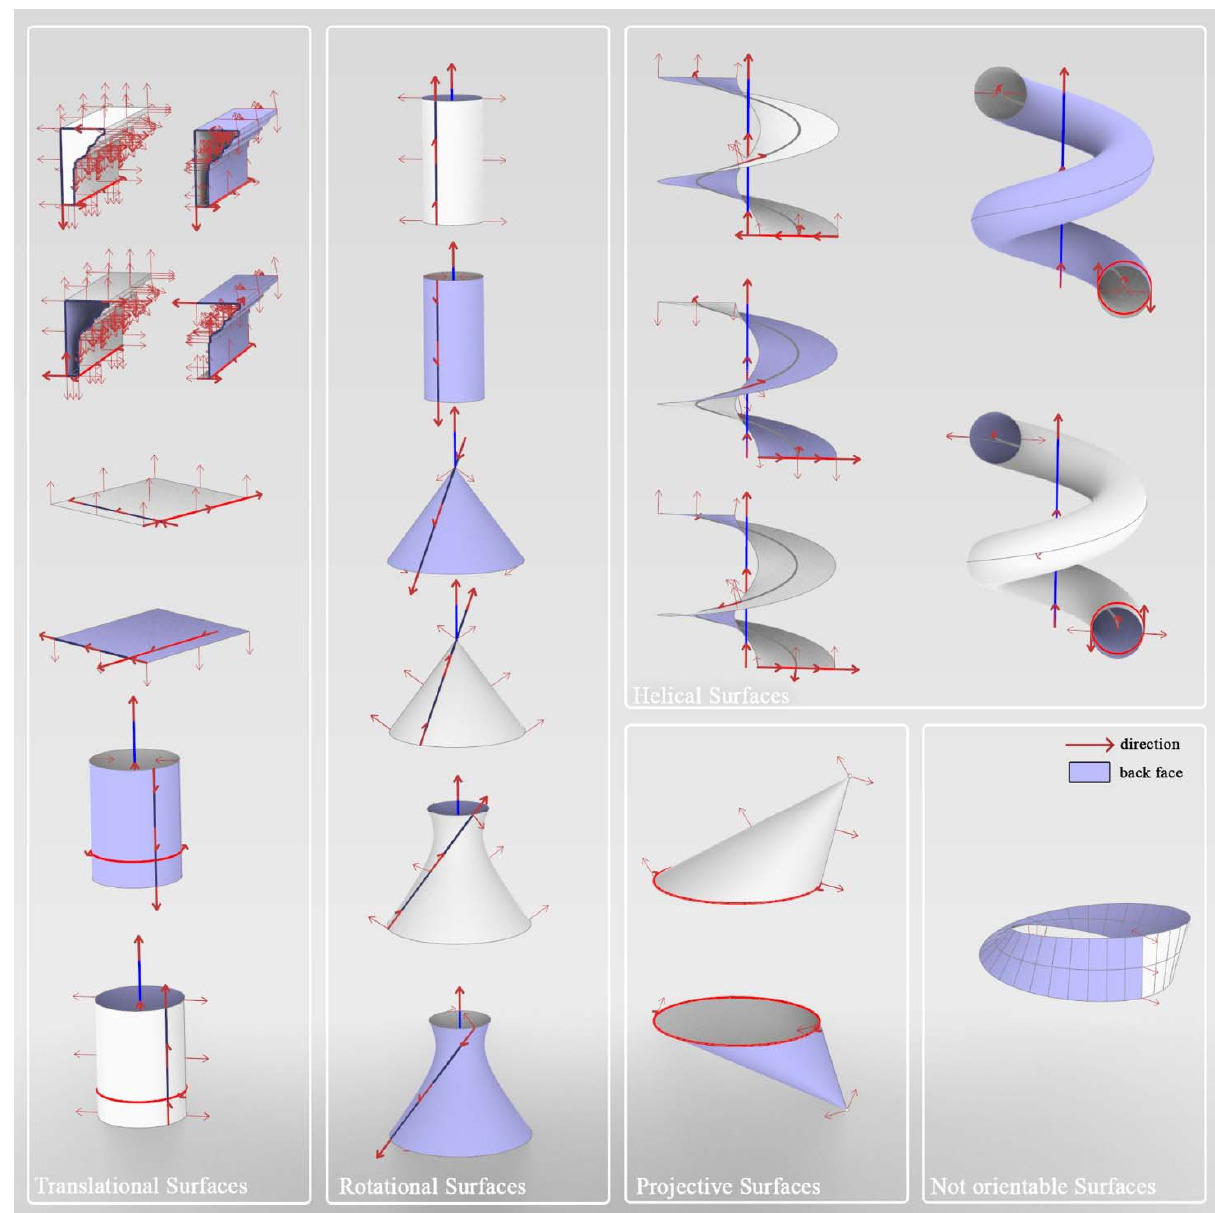
Figure 4: Relationships between geometric surface generation and normal directions.